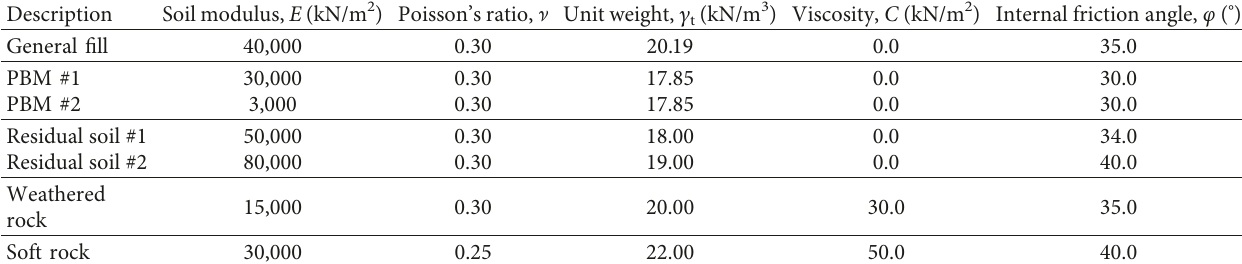
Figure 3: Measurements of GFRP pipe deflections. (a) Locations of measurement. (b) Laser distance meter and taking measurements. Table 2: Characteristics of the soil materials